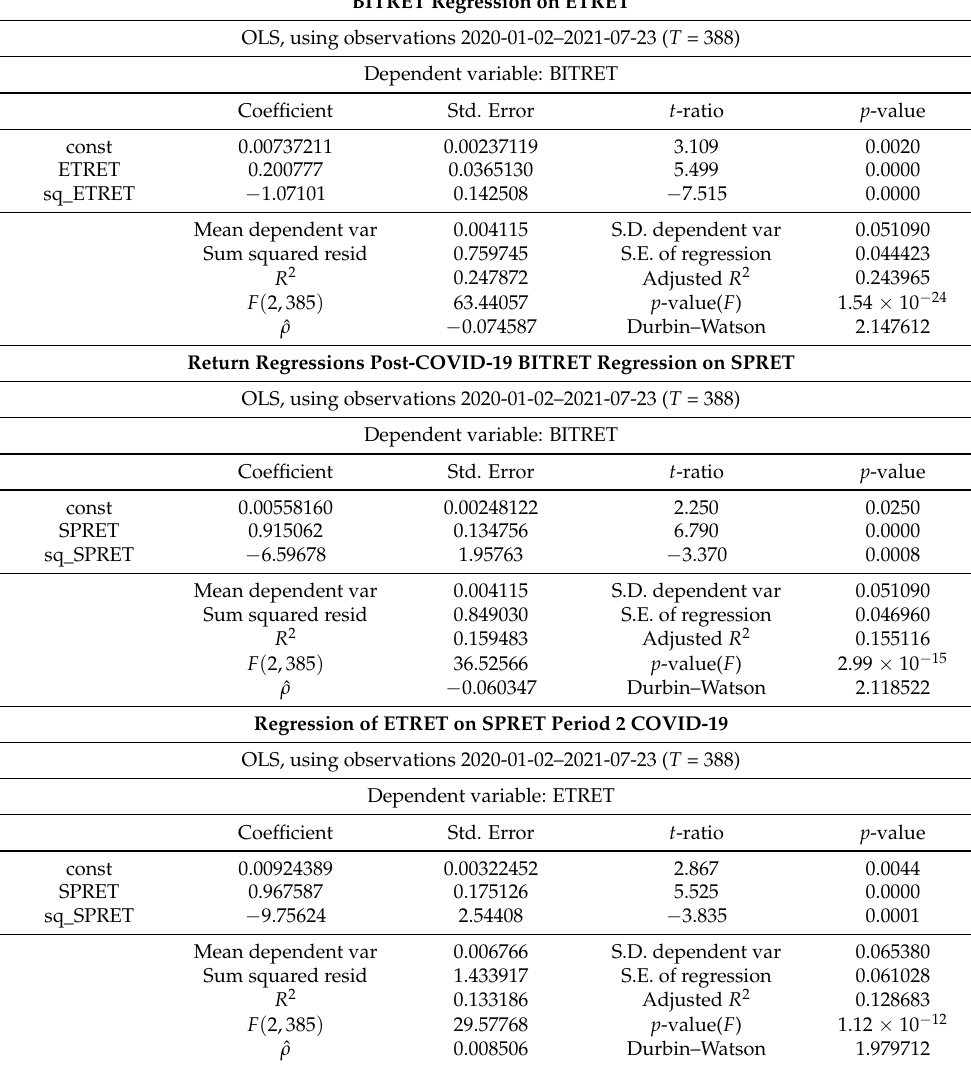
Table 6. Return regressions post-COVID-19.